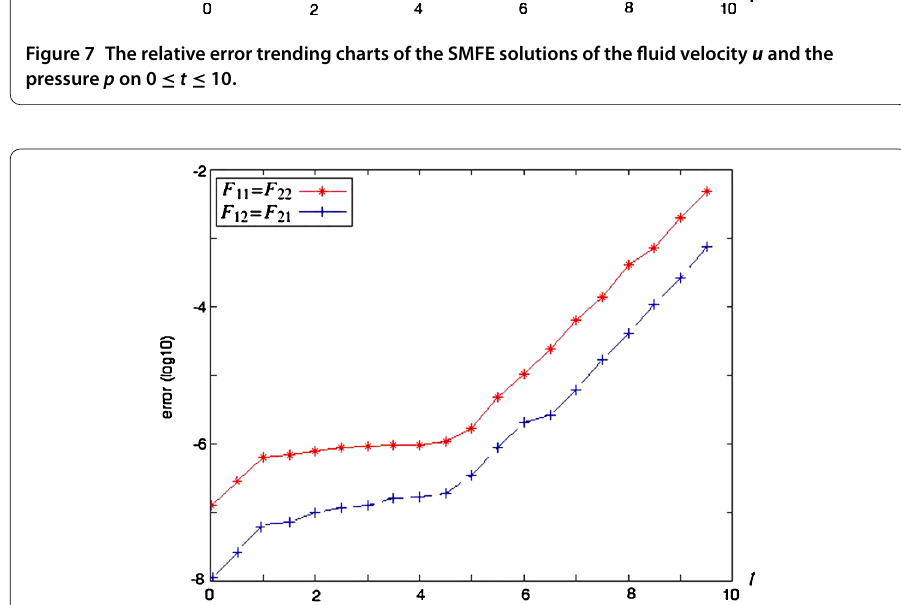
Figure 8 The relative error trending charts of the SMFE solutions of the deformation tensor F = ( F lm ) 2 × 2 on 0 ≤ t ≤